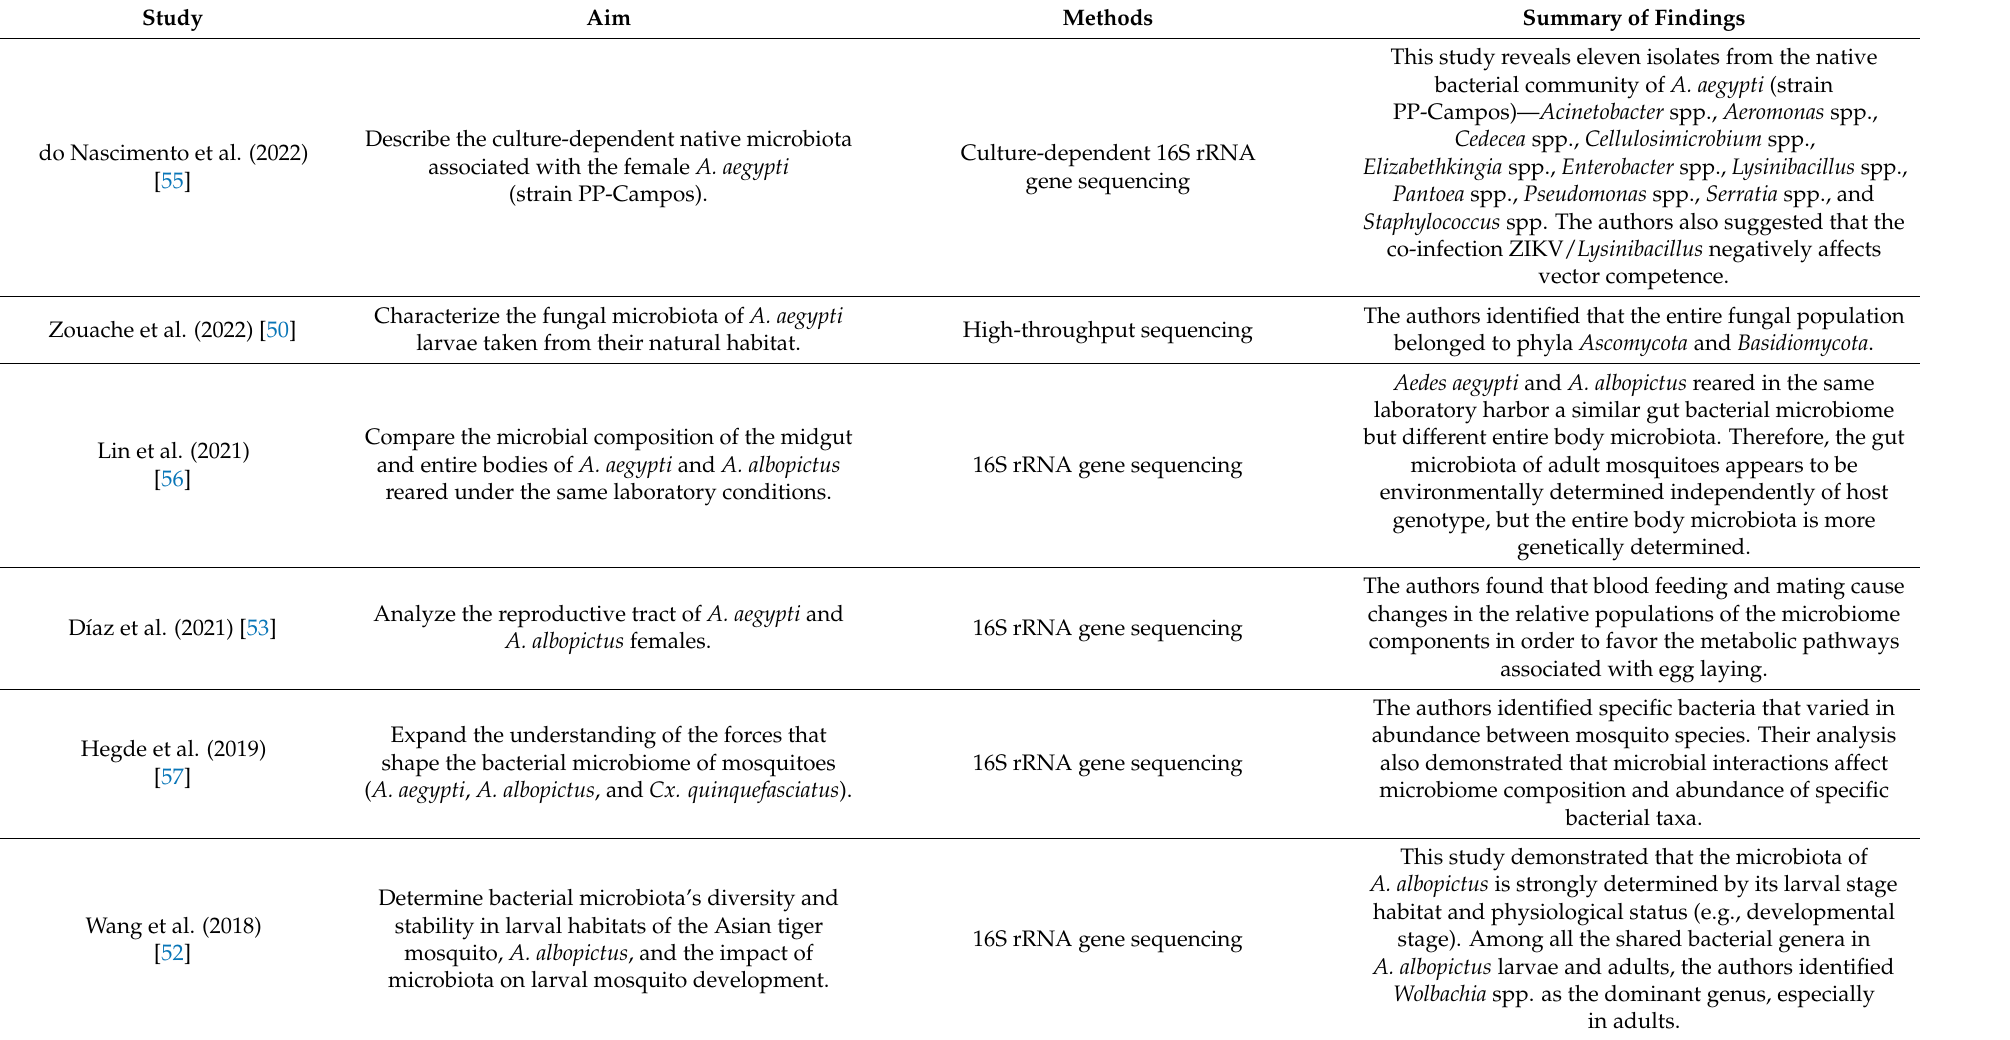
Table 1. Findings of the studies on the microbiome composition of Aedes